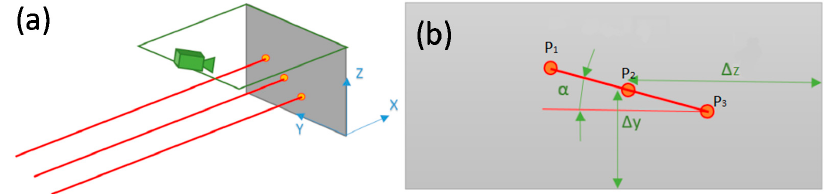
Figure 2. Laser spots on the projection plane ( a ) and scheme of the cart rotation measurement ( b ).